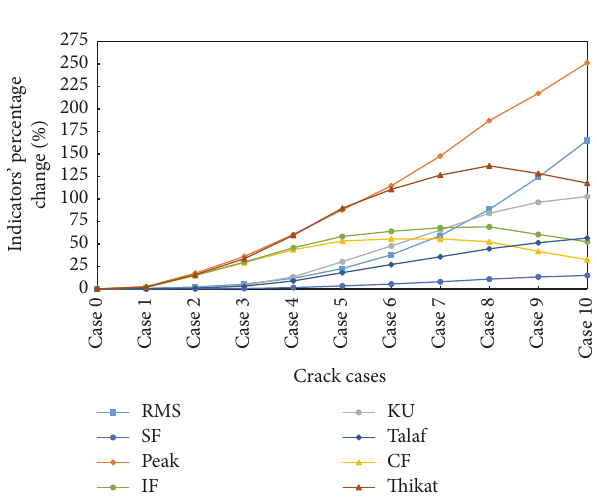
Figure 31: Performance of different time domain indicators applied to the residual signal for the third multiple-crack scenario.